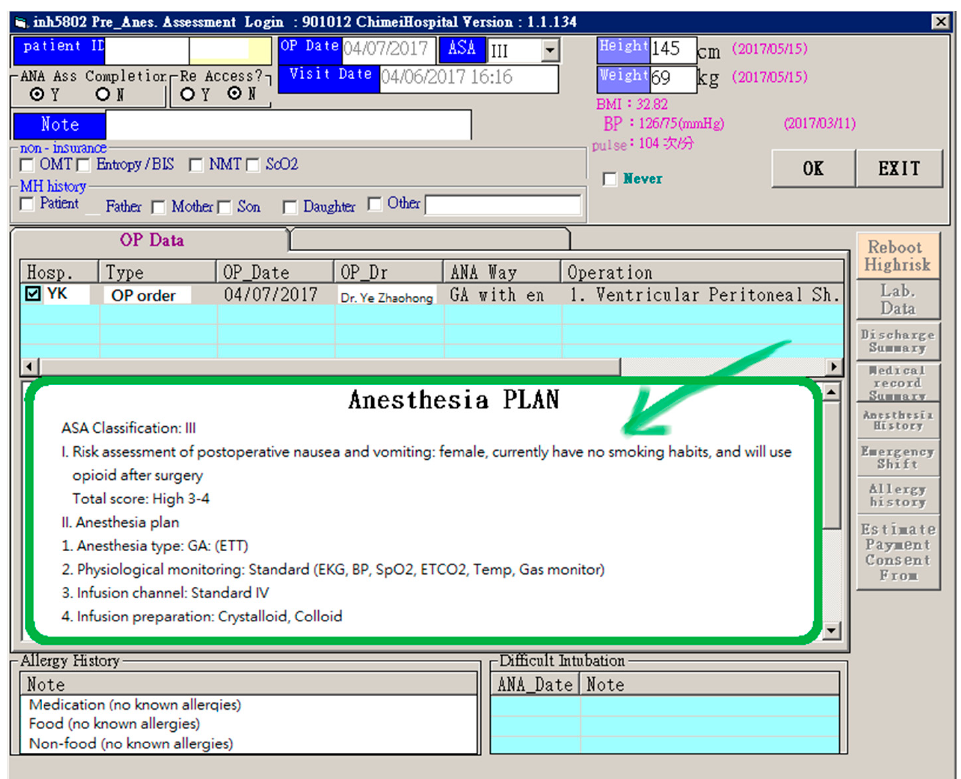
Figure 2. The adjustment of the layout of the anesthesia plan (optimized in the existing anesthetic